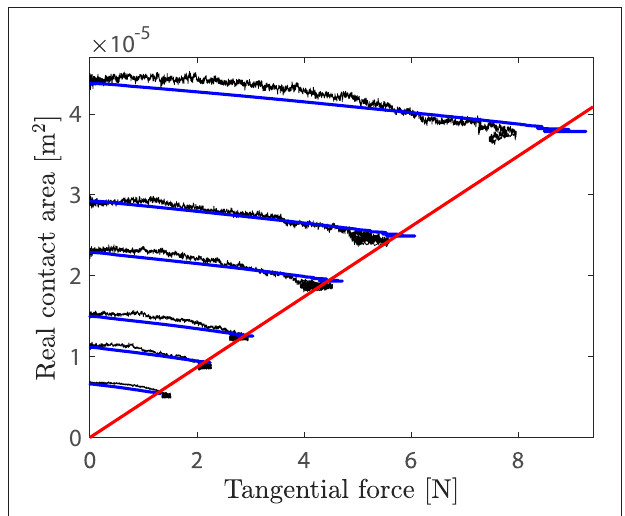
FIGURE 4 | Real area of contact vs. tangential force for the six experiments. Black (blue) curves show the measured (predicted) data. The red line has slope 1 and passes through the σ exp